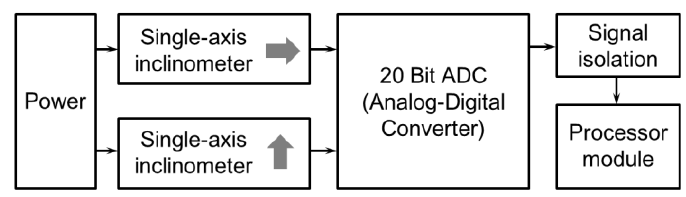
Figure 3. Block diagram of the tilt sensor module.